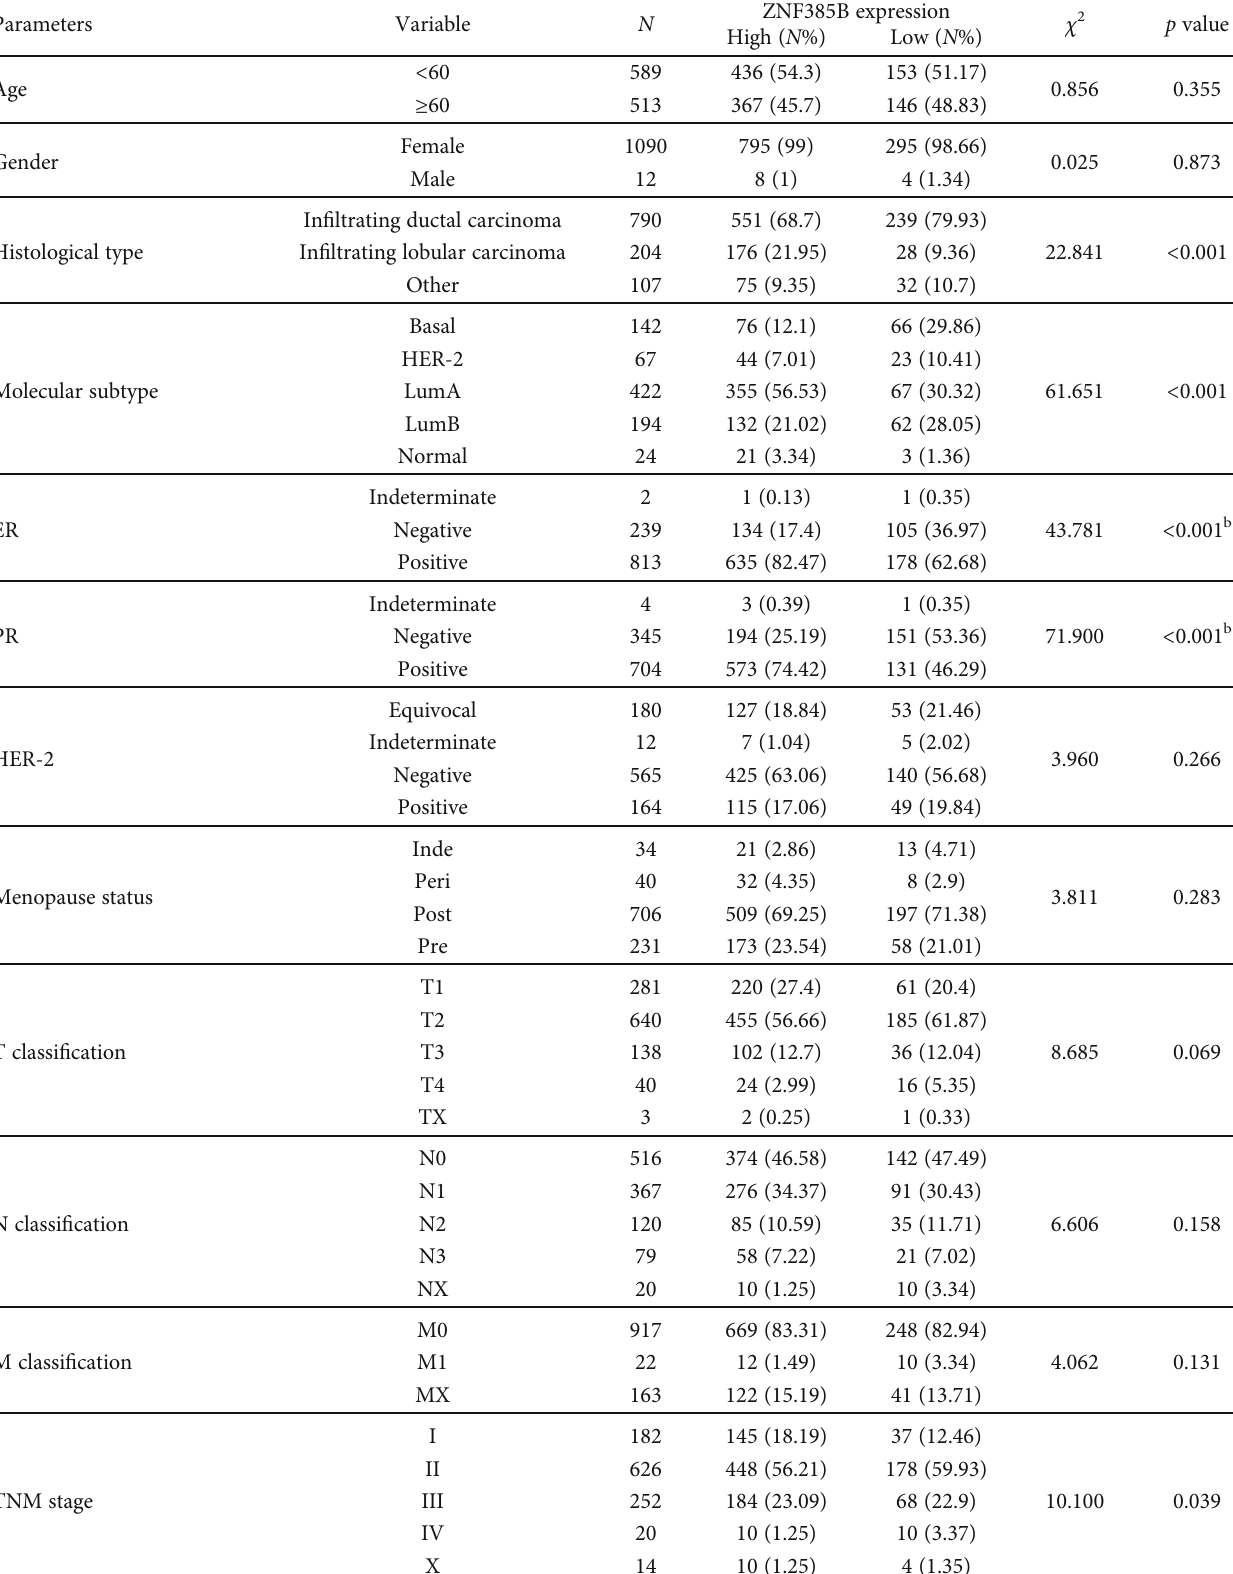
Table 2: Correlation between clinicopathological characteristics and ZNF385B expression in breast cancer patients ’ samples.